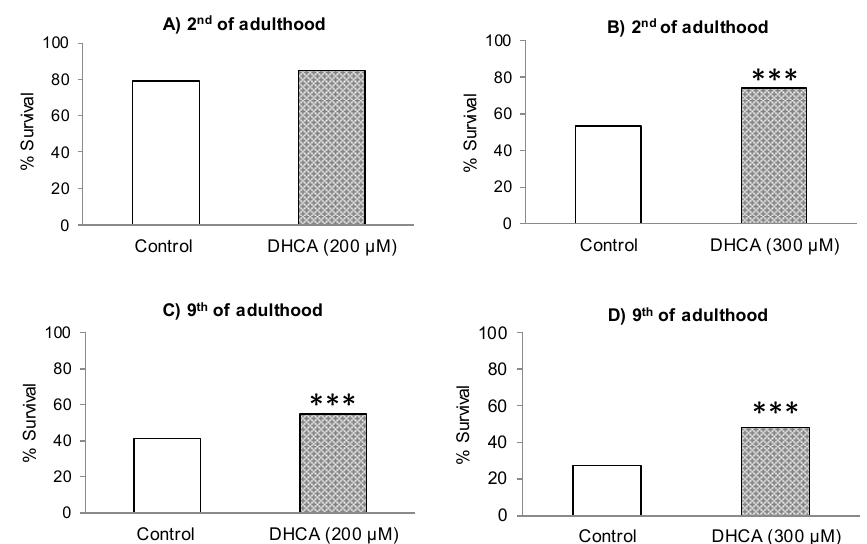
Figure 3. Survival percentages of C. elegans subjected to thermal stress (35 °C, 8 h) on the second and ninth day of adult, grown in the absence (controls) or presence of 200 μ M of DHCA ( A and C ) or 300 μ M of DHCA ( B and D ). The number of worms used in each assay was 300. The statistical significance was calculated using the Chi Square test (** p < 0.01 and *** p < 0.001).